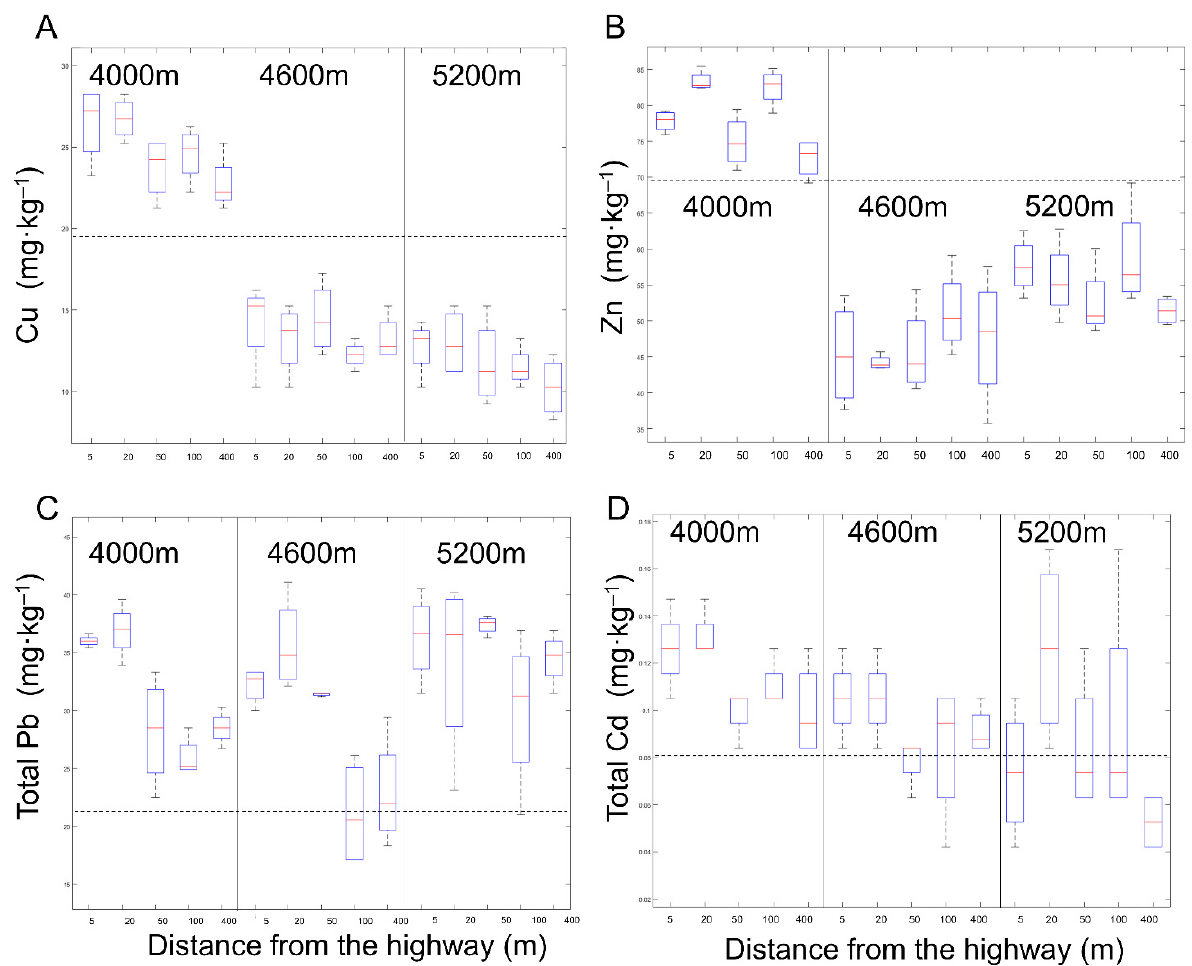
Figure 5. Concentrations of Cu ( A ), Zn ( B ), Pb ( C ), and Cd ( D ) in the 0–20 cm soil in sites 5, 20, 50, 100, and 400 m away from the G109 highway at altitudes of 4000 m (L), 4600 m (M), and 5200 m (H). The dotted line in the figure represents the background value of heavy metals in the Qinghai-Tibet Plateau.